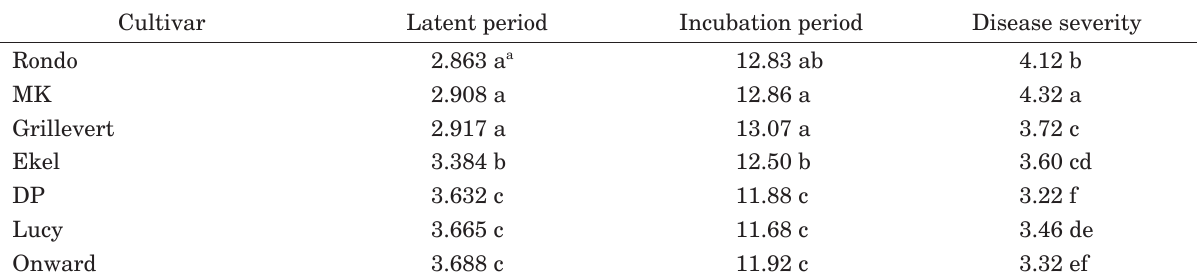
Table 3. Mean disease severity (DS), latent period (LP), and incubation period (IP) of seven commercial cultivars exposed to isolates of Mycosphaerella pinodes.